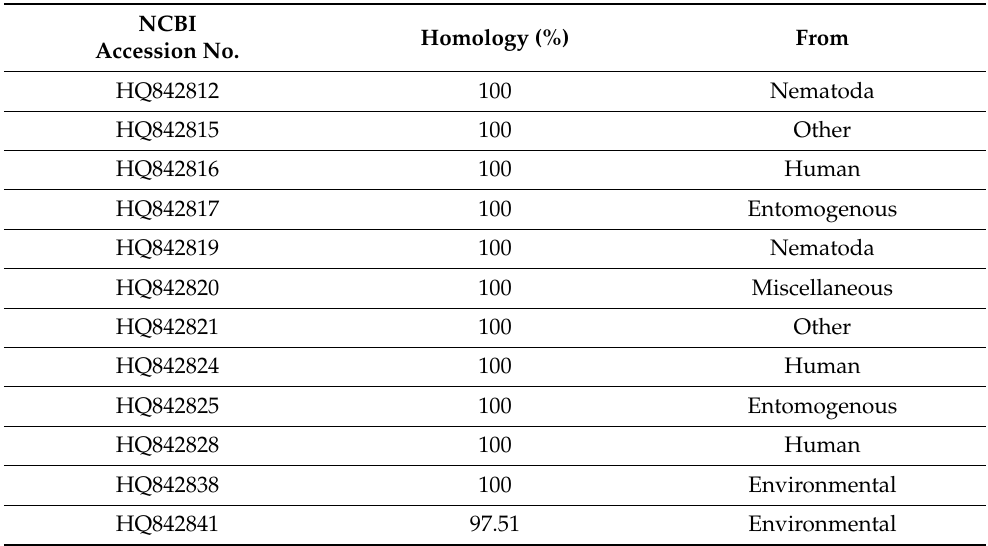
Table 1. Sequence homology of the rRNA ITS regions of isolate 1925-1 with previously identified P. lilacinum strains considered by Luangsa-Ard et al. [18]. NCBI Accession No.